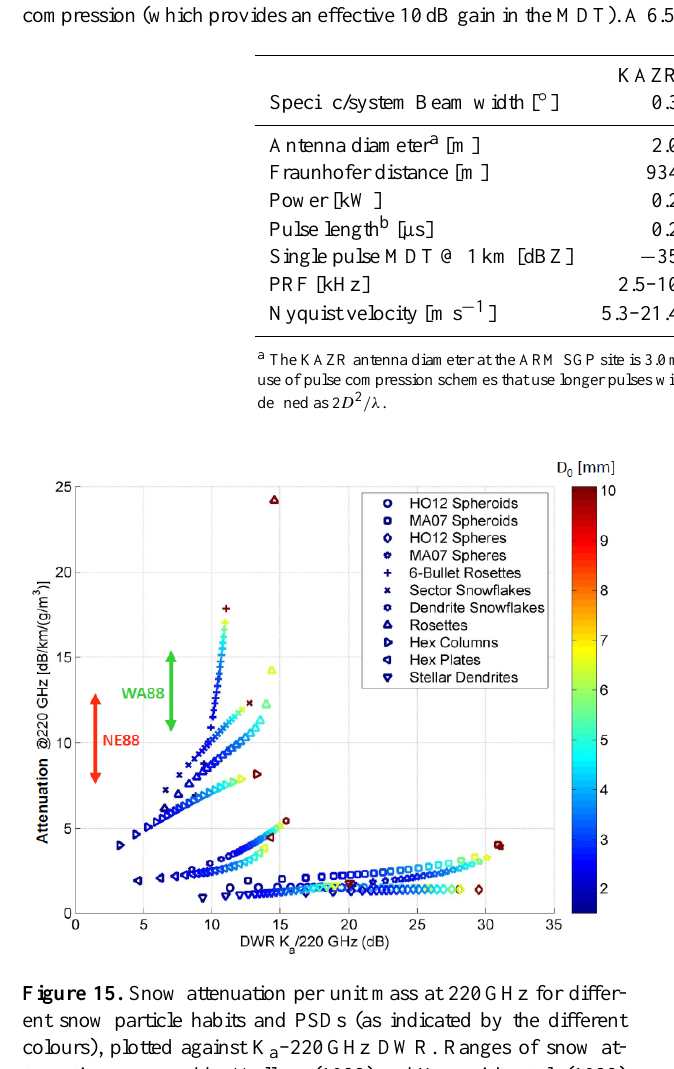
Table 1. Specifics for a dual-frequency system involving a G band radar at 220GHz for cloud studies. The KAZR system uses pulse compression (which provides an effective 10dB gain in the MDT). A 6.5dB noise figure has been used for all systems to compute the MDT.